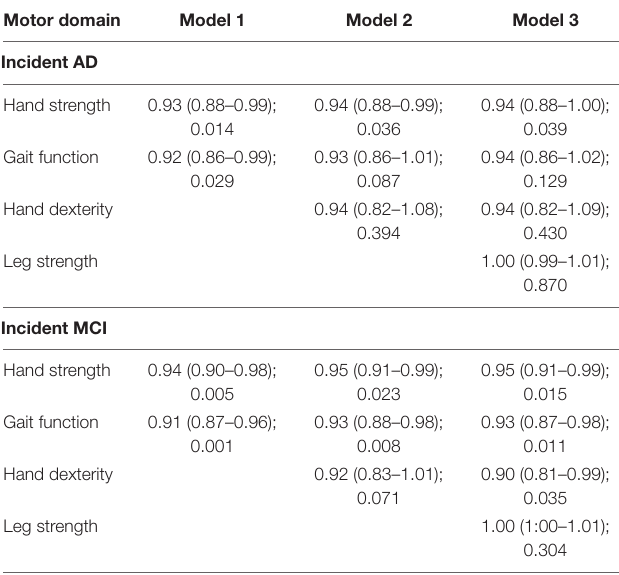
TABLE 4 | Associations of individual motor domains driving the associations of global motor score with incident AD and incident MCI (HR: 95% CI; p